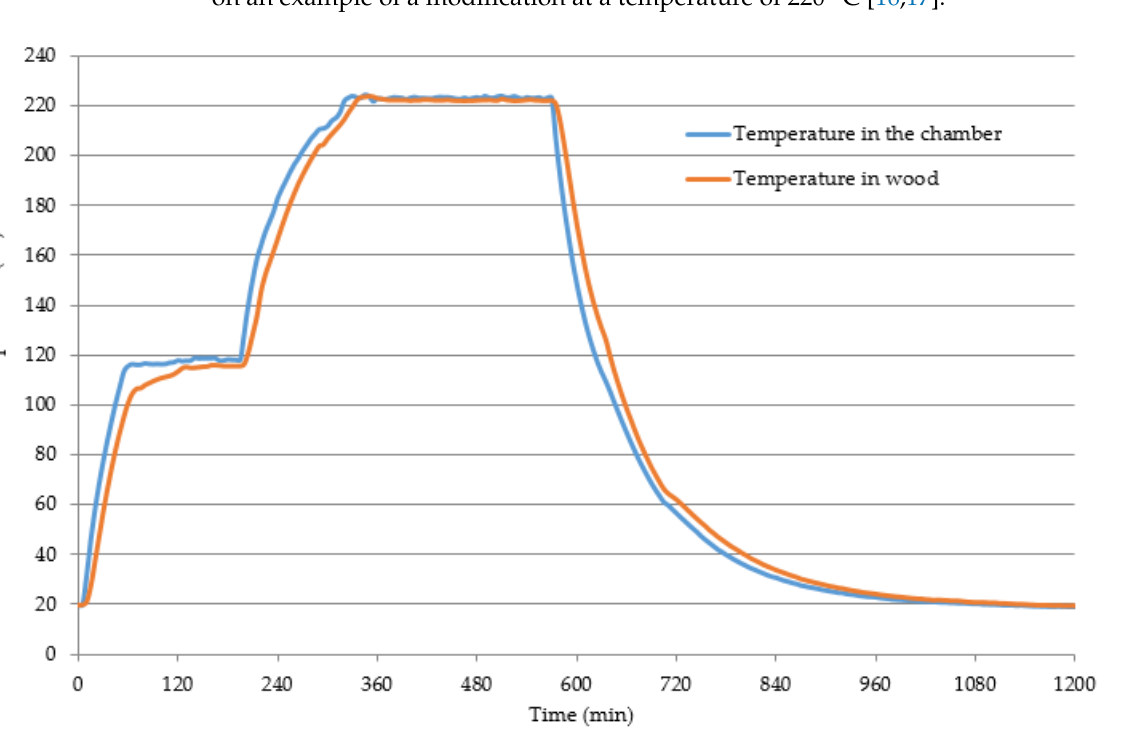
Figure 1. The course of the wood modification process (temperature 220 ◦ C, time 4 h)